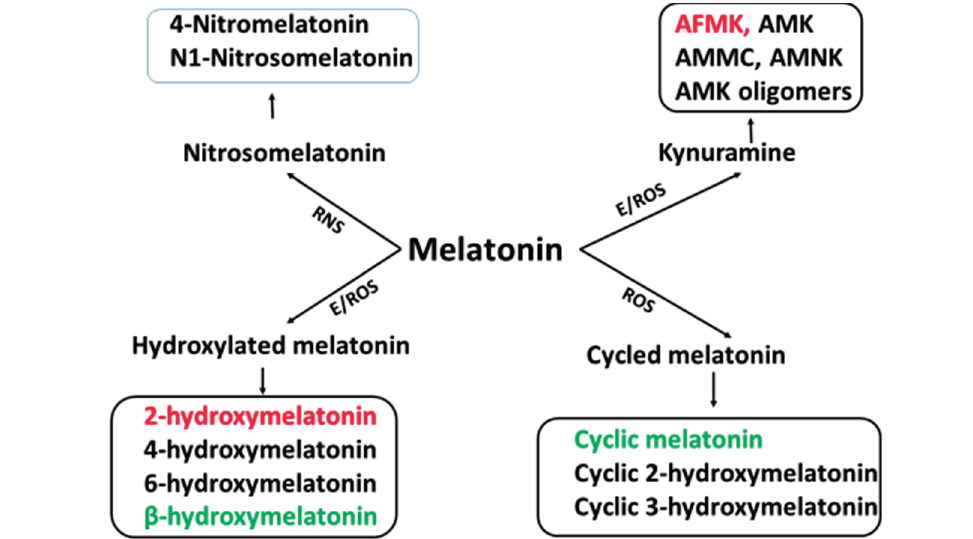
Figure 2. The profiles of melatonin metabolites. ROS: reactive oxygen species; RNS: reactive nitrogen species; E: enzymes including cytochrome P450 (CP450), indoleamine 2 3-dioxygenase (IDO), horseradish peroxidase (HRP), myeloperoxidase (MPO), eosinophil peroxidase (EPO), melatonin 2-hydroxylase (M2H). Black occurs only in animals; green occurs only in plants; red occurs in both animals and plants. AFMK: N 1 -acetyl- N 2